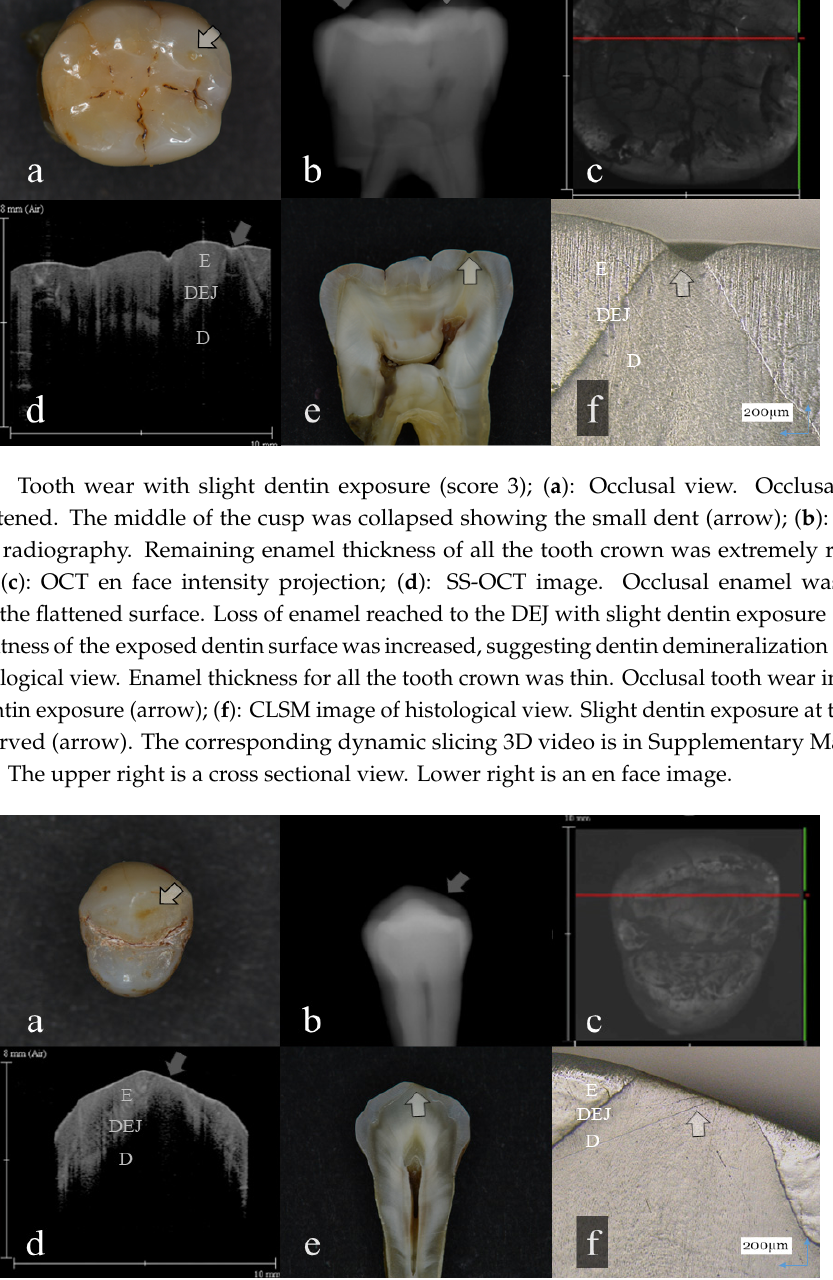
occlusal distal surface was thinned (arrow); ( c ): OCT en face intensity projection; ( d ): SS-OCT image.